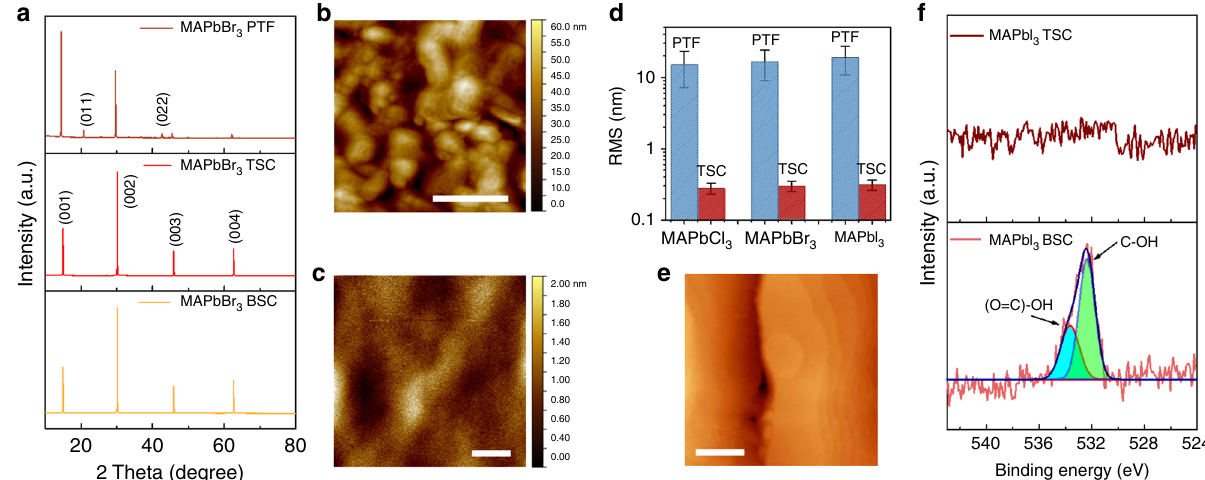
Fig. 2 Microstructure and surface properties of TSCs. a XRD data comparing the polycrystalline thin fi lm (PTF) to the TSC and bulk single crystal (BSC) forms of MAPbBr 3 . Surface topography of a MAPbBr 3 PTF ( b ) and that of a TSC ( c ) as measured by AFM, of which the root mean squared (RMS) roughness for PTF and TSC are 16.5 and 0.21 nm, respectively. Scale bar: 400 nm. d RMS surface roughness of MAPbX 3 (X = Cl, Br, and I) polycrystalline fi lm and TSCs. The error bar re fl ects the statistical variation in roughness in different parts of the sample. e Scanning tunneling microscopy (STM) image of the surface region near the edge of a MAPbBr 3 TSC. Scale bar: 50 nm. f XPS spectra of the surface of MAPbI 3 TSC and